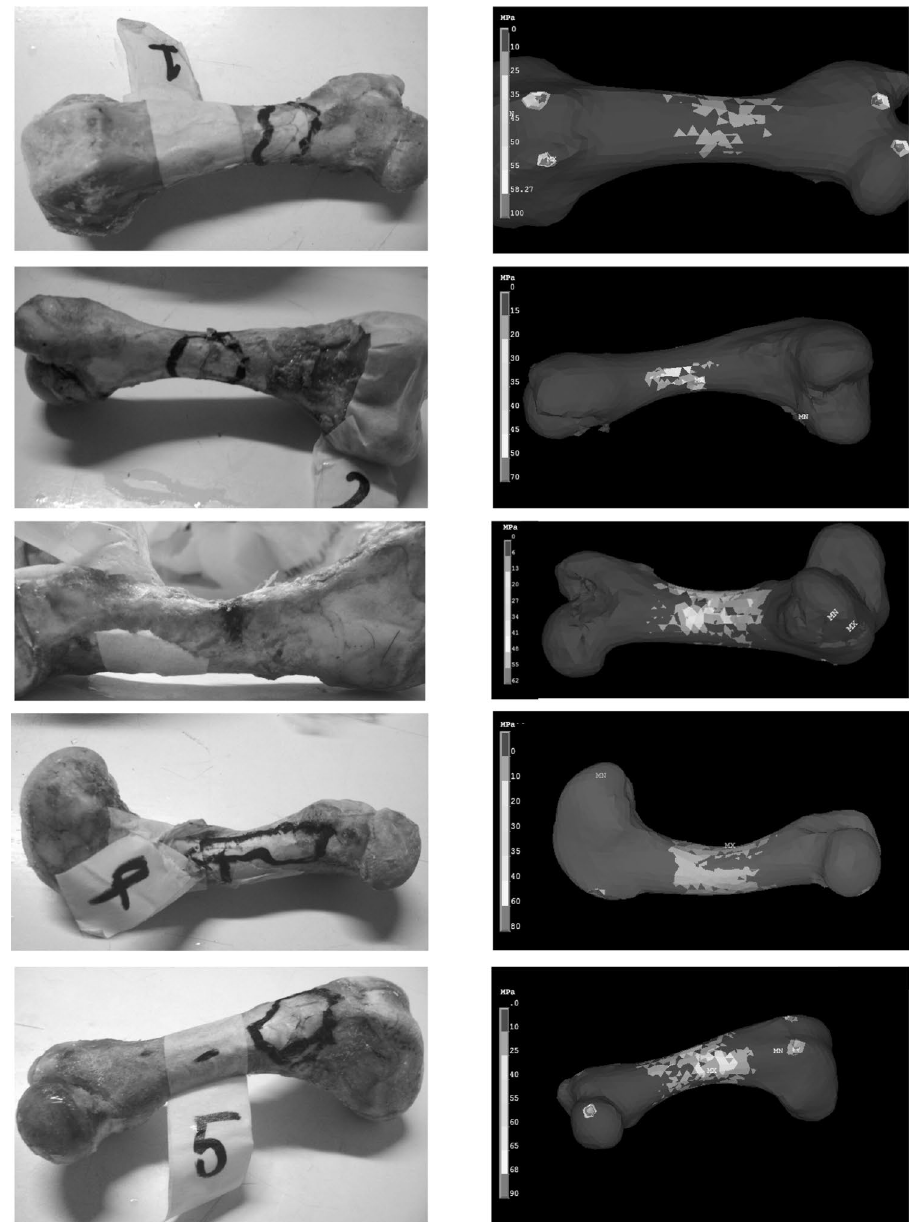
Fig. 10 Comparisons of local damage (fracture sites) between the real three-point bend tested animal models and computational